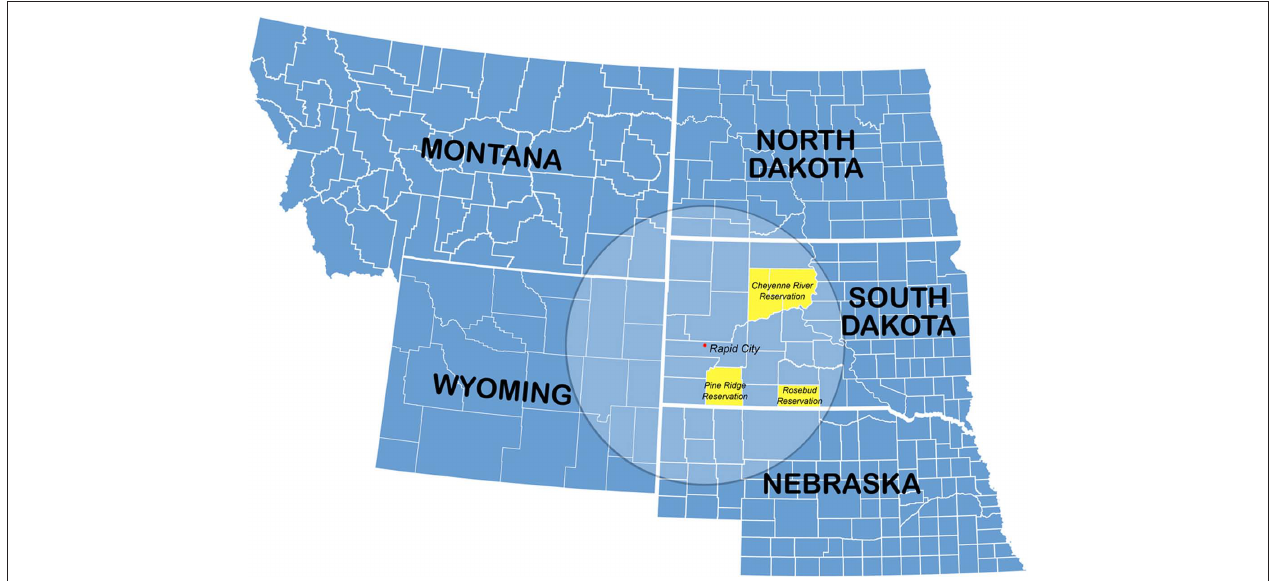
FIguRe 1 | geographic area served by Walking Forward (radius shown 180